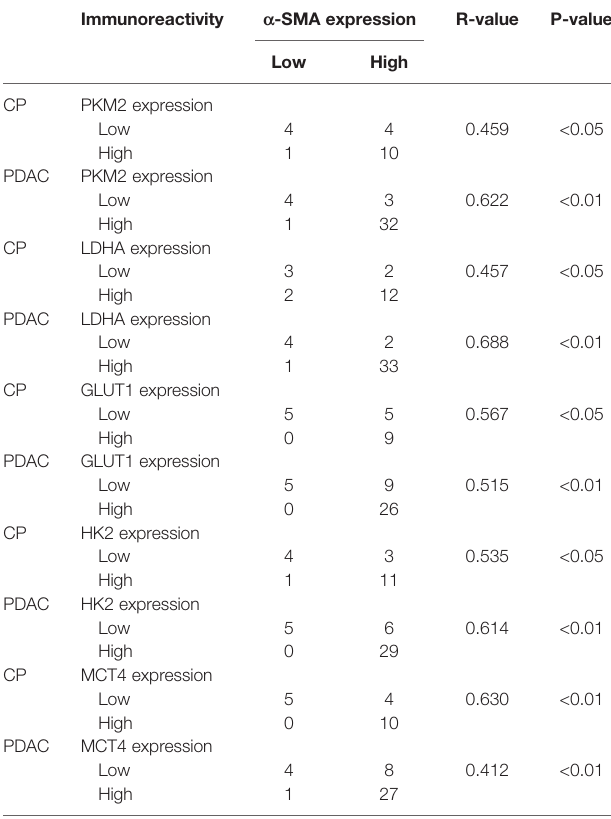
TABLE 5 | Correlations of a -SMA expression with glycolysis markers (PKM2, LDHA, GLUT1, HK2 and MCT4) in CP/PDAC tissues. Immunoreactivity a -SMA